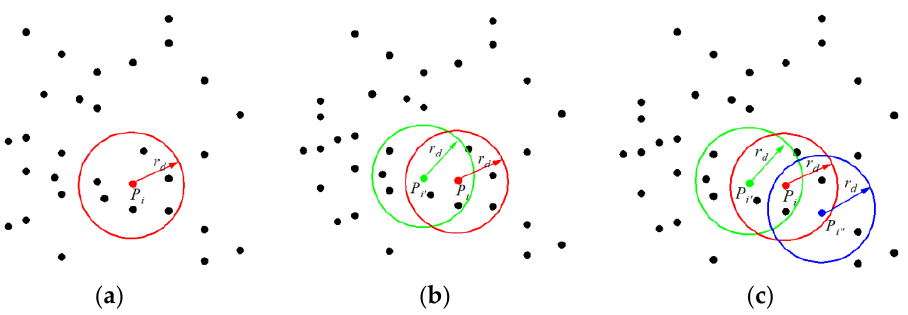
Figure 5. Schematic diagram of neighborhood search: ( a ) first step; ( b ) second step; ( c ) third step.